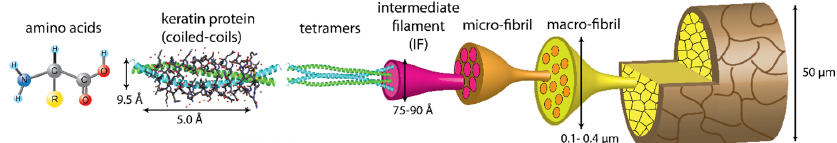
Figure 1. Structure of keratin. Adapted from work in [12] under the Creative Commons Attribution 4.0 International license (https://creativecommons.org/licenses/by/4.0/deed.en).